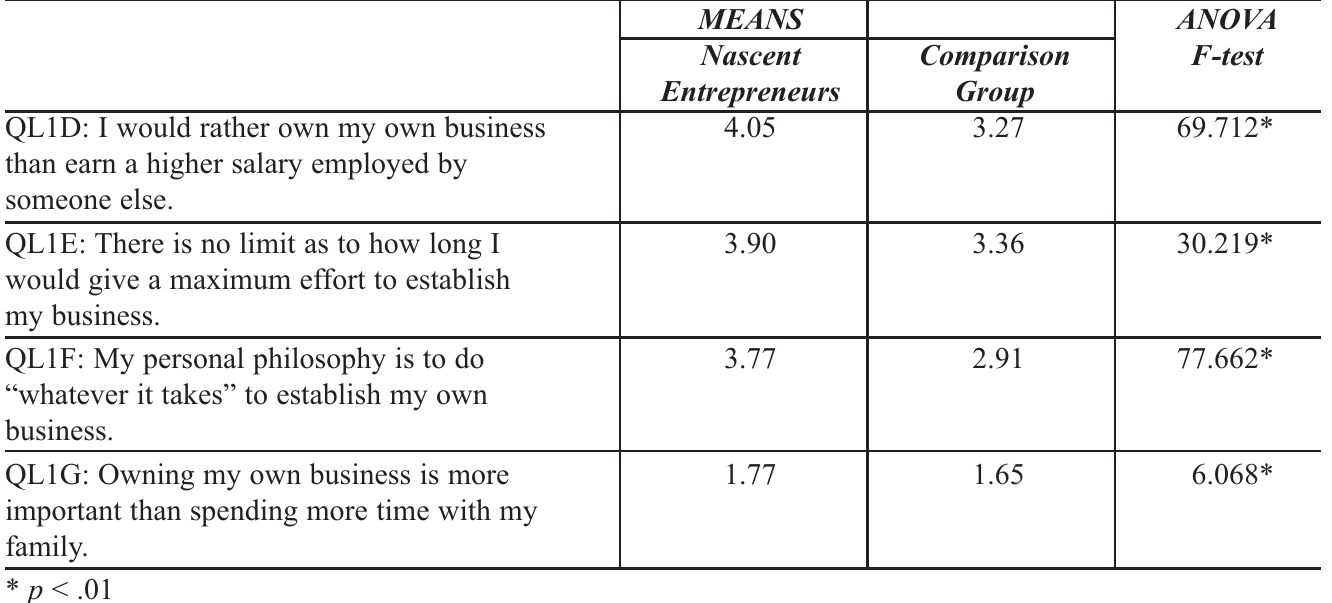
Table 2. Analysis of Variance: Nascent Entrepreneurs and Comparison